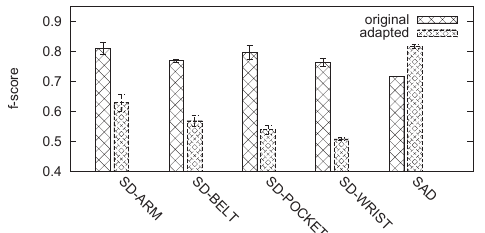
Figure 10: Performance(f-score) improvement by in- corporating magnetometer features, we do not ex- periment on dataset UCI as it does not provide mag- netometer data.